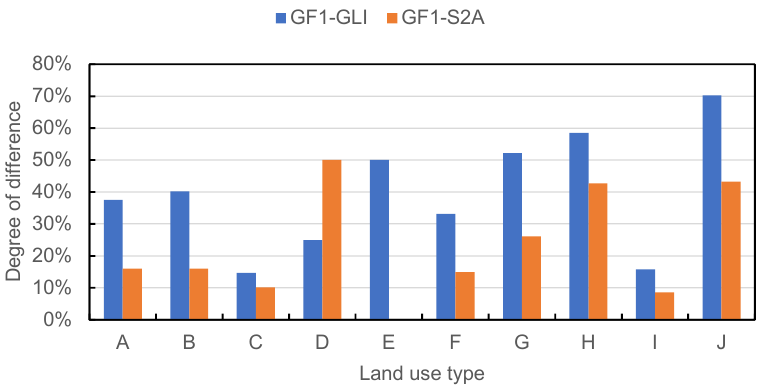
Figure 6. The DD between different resolutions of data in blocks with different land use types.